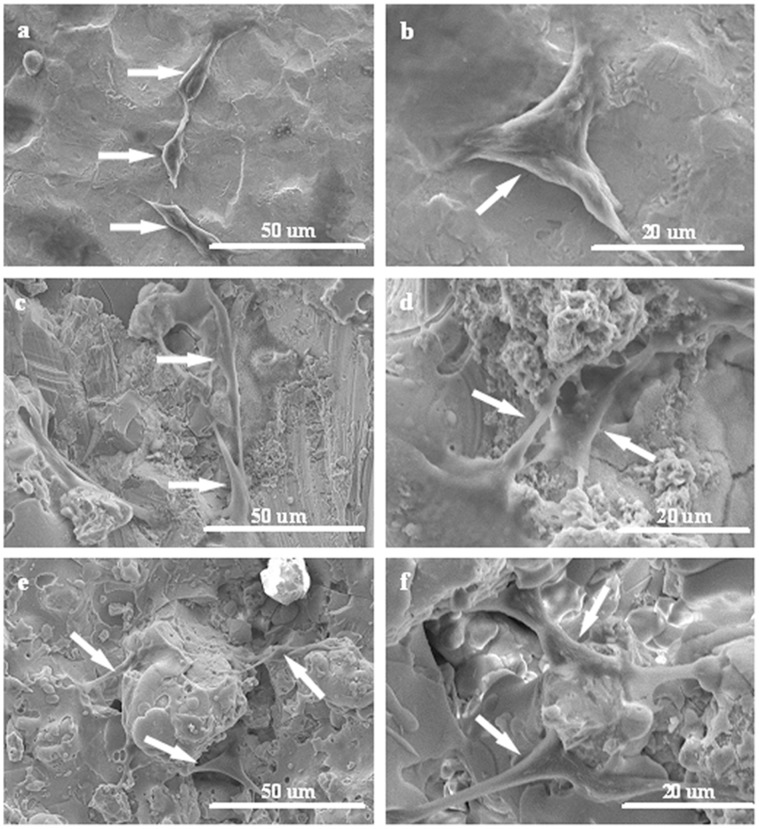
SEM images of MC3T3-E1 cell morphology on the different substrates 24 h after seeding:(a, b) control, (c, d) CaSiO3 coating and (e, f) Ca2ZnSi2O7 coating.The arrows indicated cells cultured on the different substrates.